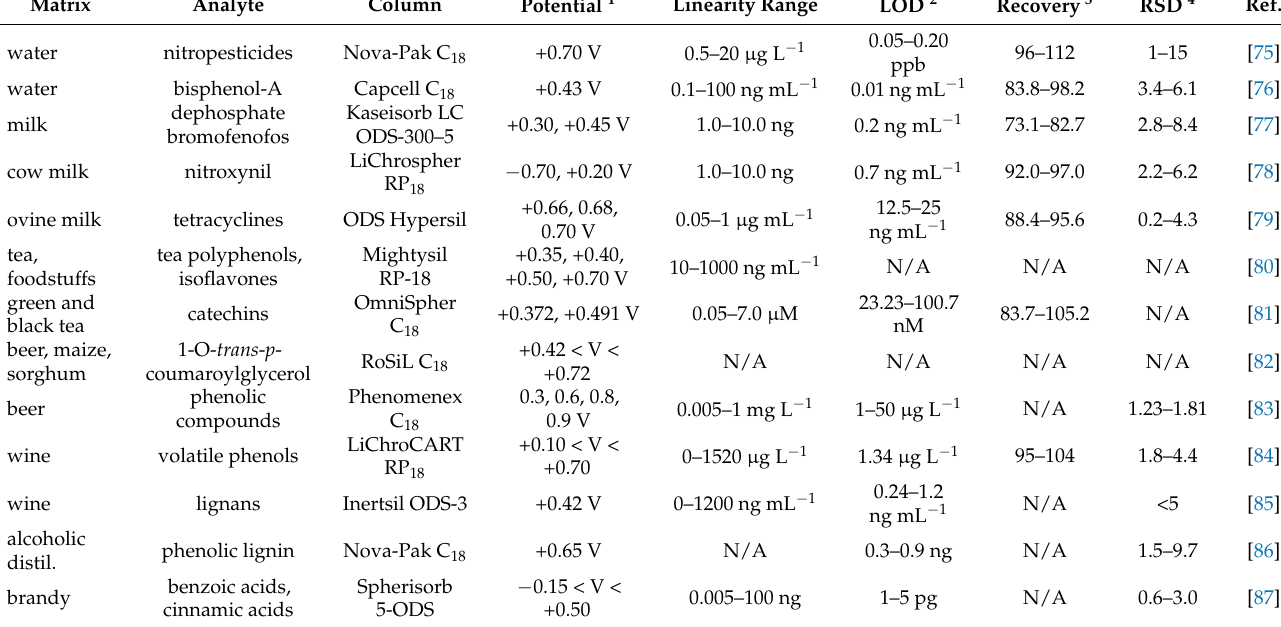
Table 5. HPLC-ED analysis performance in the analysis of different compounds in beverage matrix. The term “N/A” means the information is absent in the